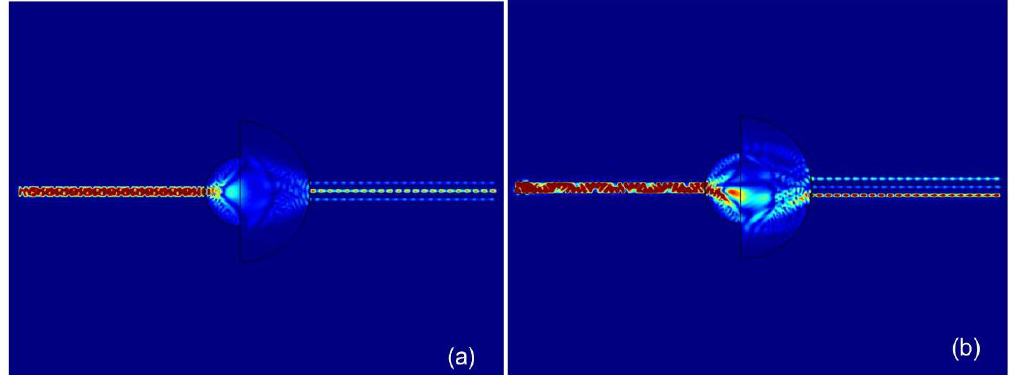
Figure 6. COMSOL Multiphysics simulations of a Maxwell fisheye-based mode sorter. ( a ) Symmetric excitation of the multimode input waveguide leads to the output power being channeled into the central single mode output waveguide. ( b ) Asymmetric excitation of the multimode waveguide leads to propagation of higher spatial modes, which are channeled preferentially into the side single mode waveguides. The spatial dimensions of the magnifying Maxwell fisheye lens in these simulations are the same as in Figure 1.